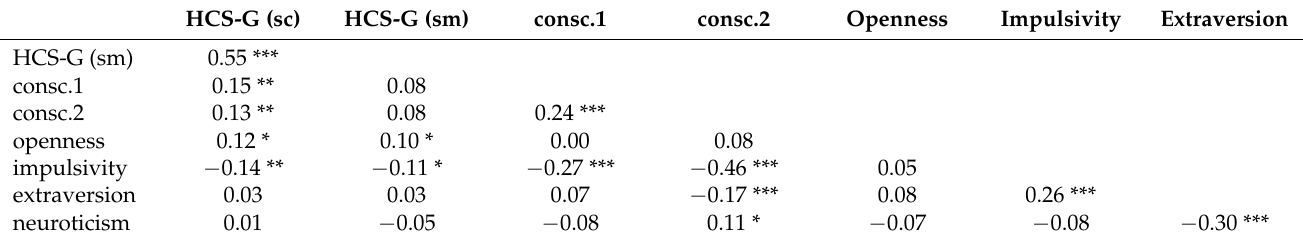
Table 5. Pearson correlations of health consciousness scales and convergent and discriminant scales.